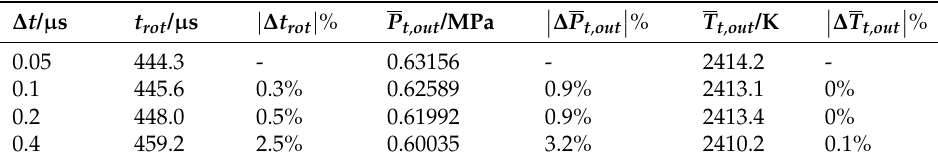
Table 2. Time step independence validation (grid size of 1